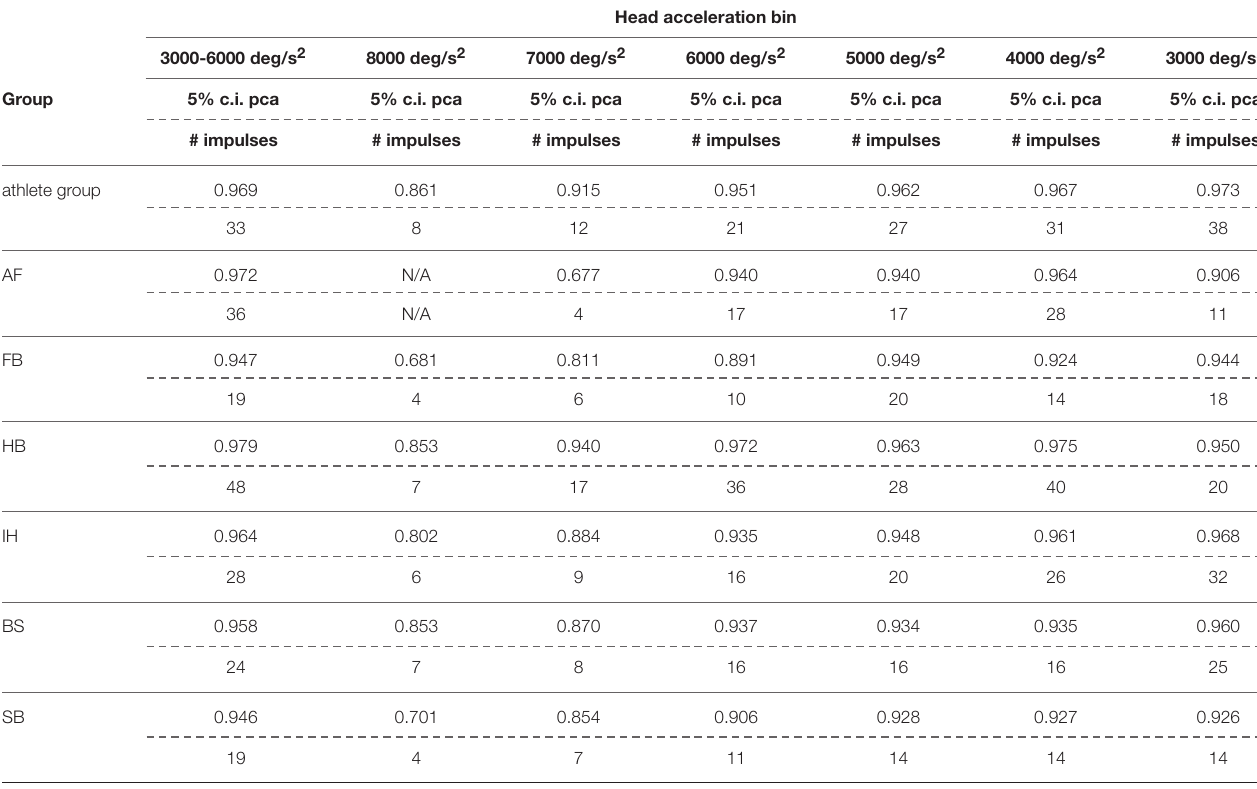
TABLE 6A | Sport specific lower boundary of pca and minimum number of head impulses to identify a deficit—horizontal